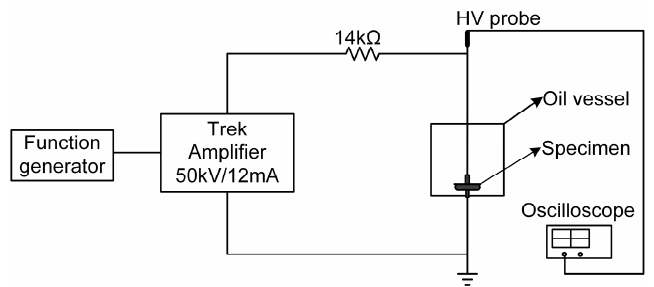
Figure 2. The setup of breakdown voltage test at different voltage waveforms.